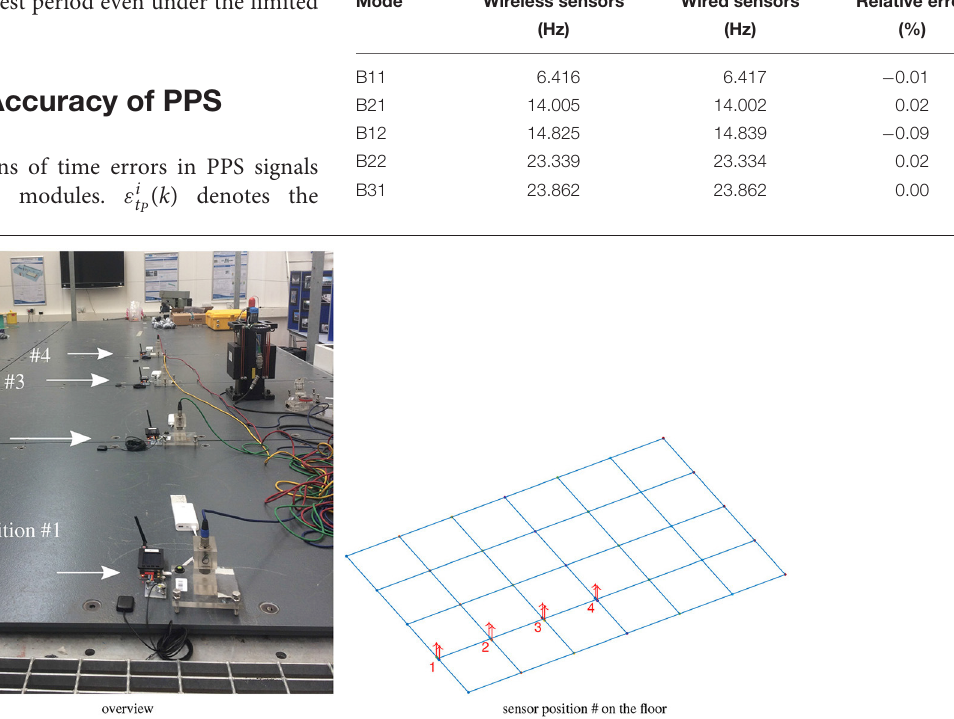
FIGURE 18 | Sensor